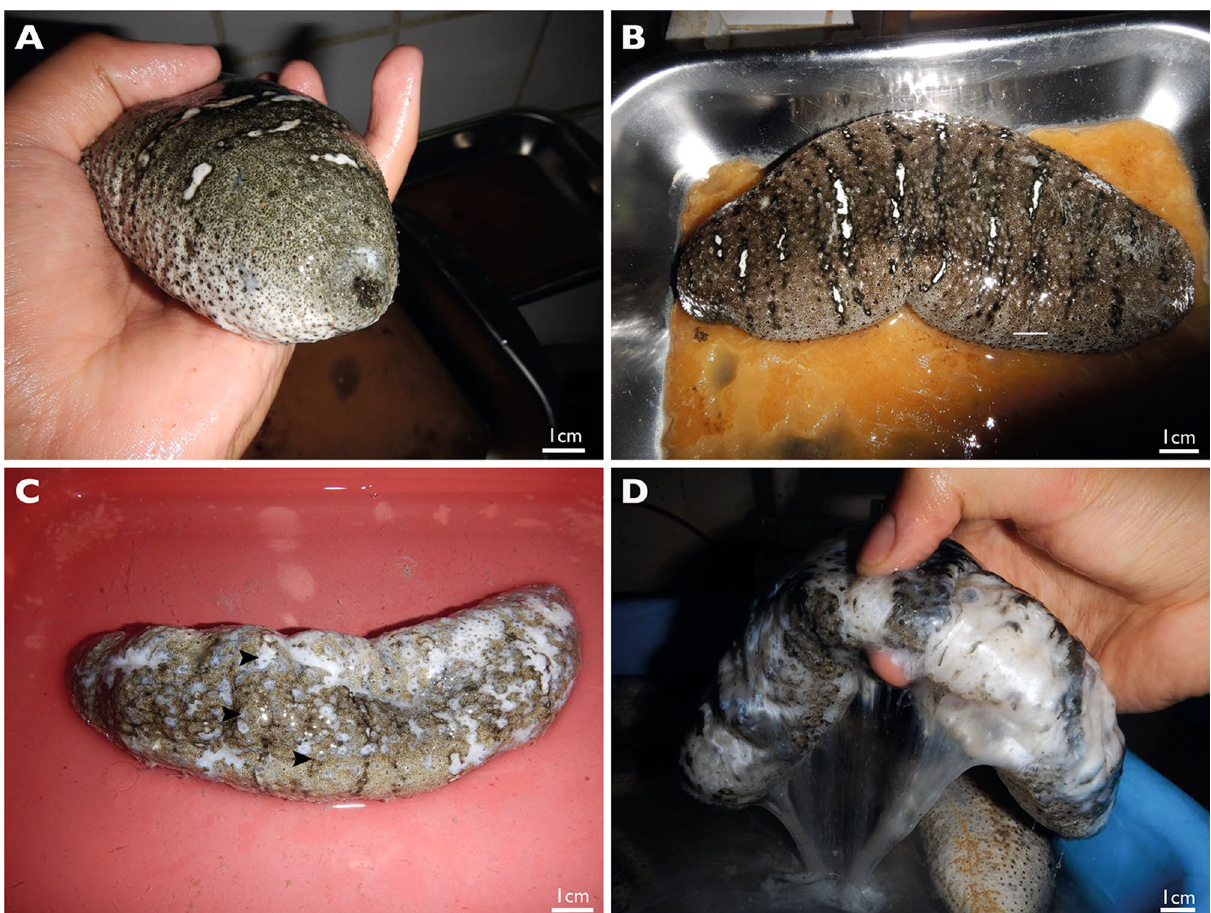
Figure 2. Phenotype characterisation of SKUD stages in H. scabra . ( A ) Stage I, ( B ) Stage II, ( C ) Stage III, ( D ) Stage